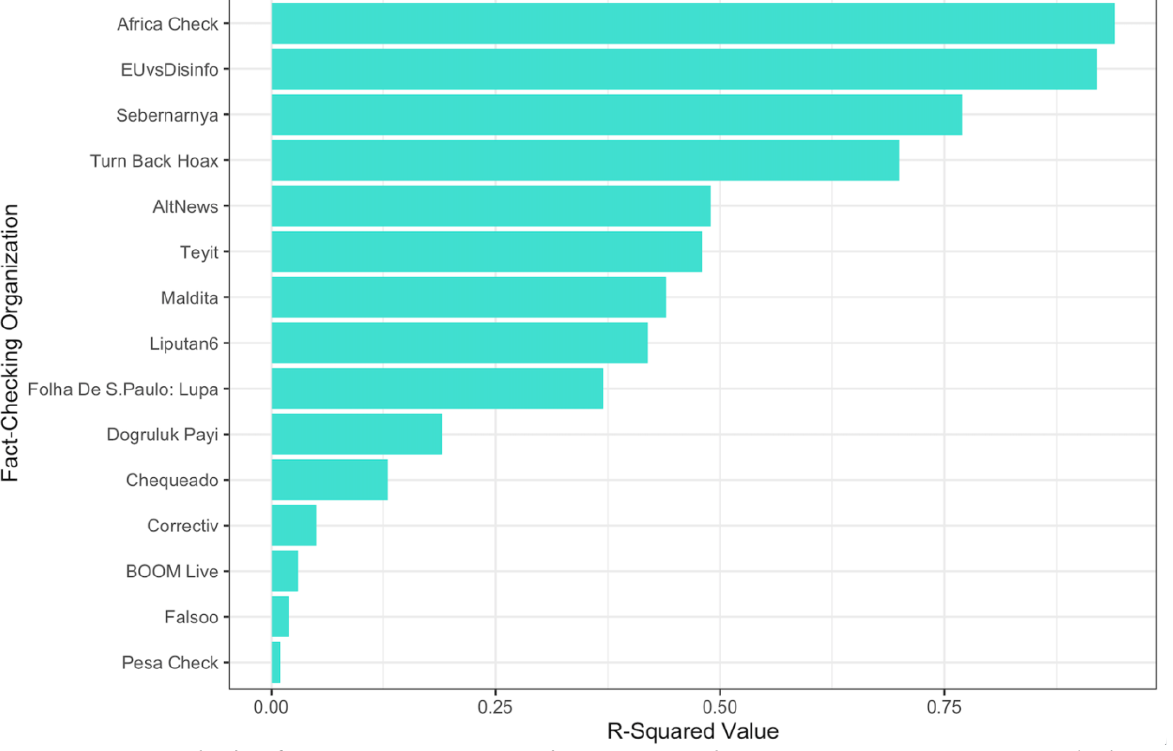
Figure 6. R-Squared Values for Association Between Total Engagement and COVID-Driven Engagement. R-Squared values show how much of change in total engagement on fact-checking content is predicted by changes in total engagement on COVID-related